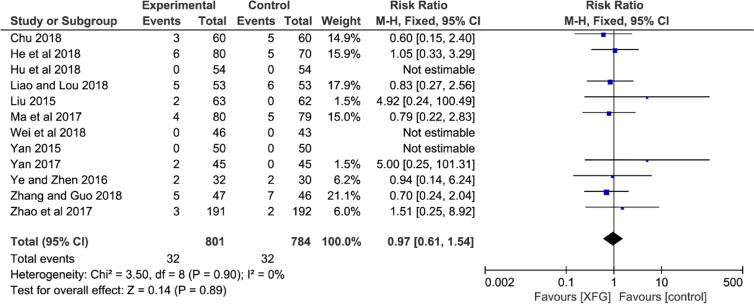
Forest plot and meta-analysis of adverse events.